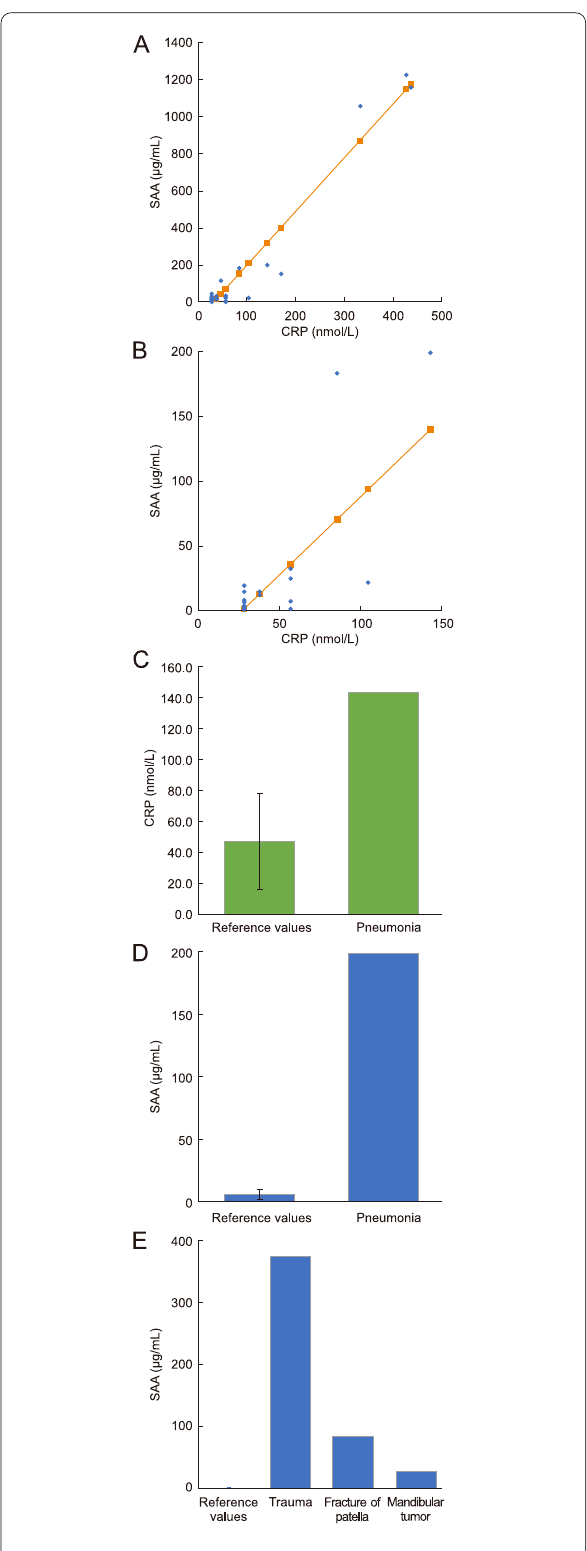
Fig. 1 A linear regression between hCRP and vSAA concentrations. A Nonhuman primates (Haplorhini). Simple regression analysis: y 2.8859x – 93.9112. Correlation coefficient r 0.9692 ( n 44). B = = = Bonnet macaques. Simple regression analysis: y 1.2086x – 33.0408. = Correlation coefficient r 0.7321 ( n 25). C , D Bonnet macaque = = with pneumonia and pulmonary emphysema. The reference value of CRP is 46.86 30.97 nmol/L ( n 24) and 9.06 1.95 μg/mL ( n 24) ± = ± = for SAA. E vSAA results in ring-tailed lemur. The reference value of SAA is 1.08 0.47 μg/mL ( n ± =